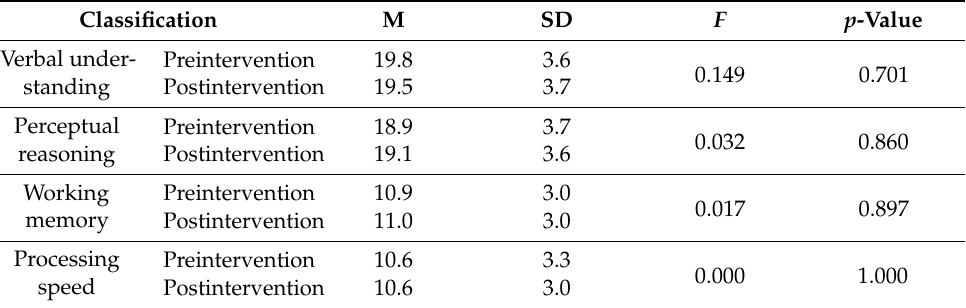
Table 8. Results of intelligence test (K-WISC-IV) sub-items on preintervention and postintervention of the conventional cognitive training